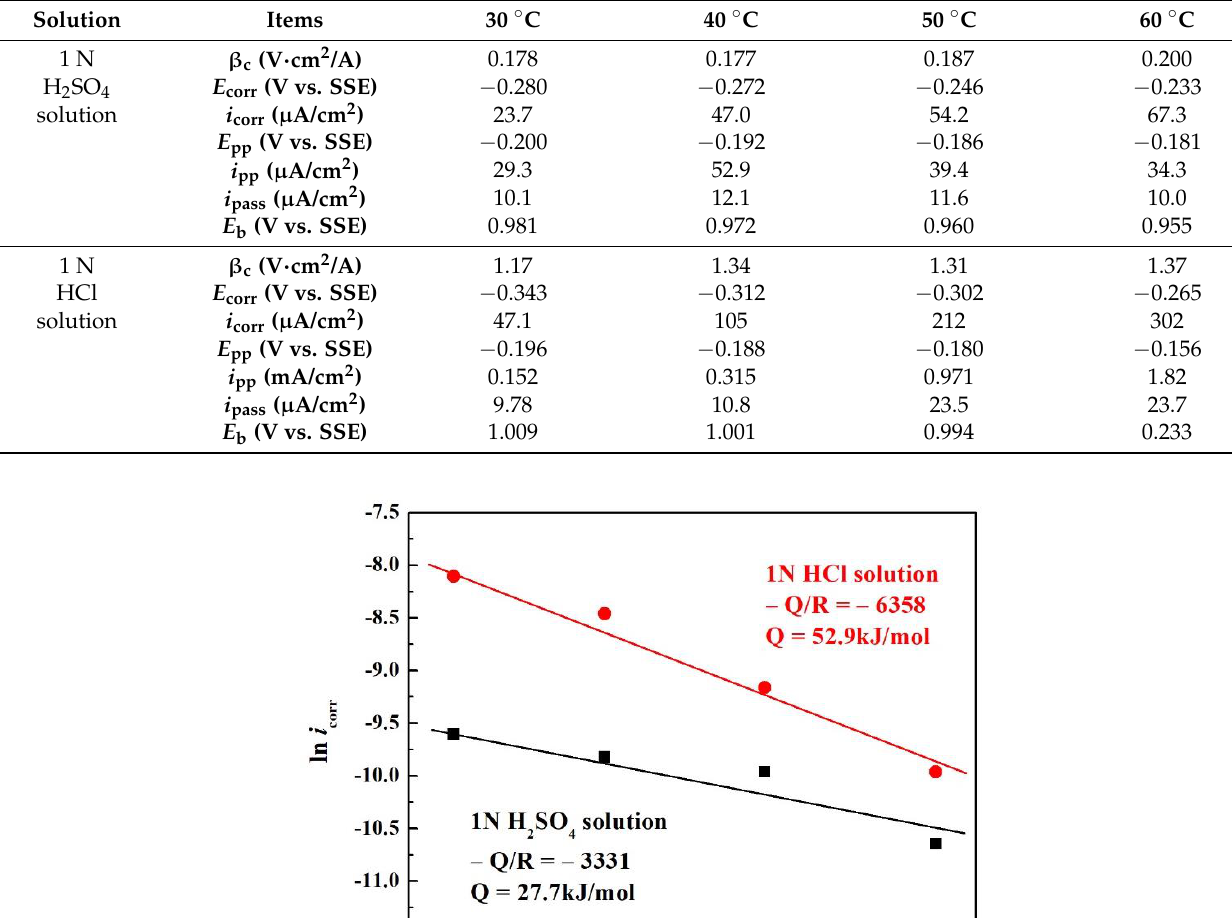
Table 2. Polarization data of the Cr 27 Fe 24 Co 18 Ni 26 Nb 5 alloy tested in deaerated 1 N H 2 SO 4 and deaerated 1 N HCl solutions. Solution